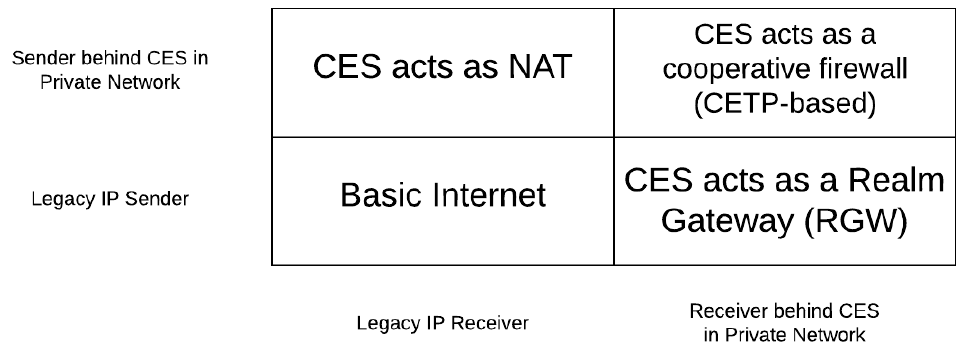
Figure 2. CES and NAT comparison